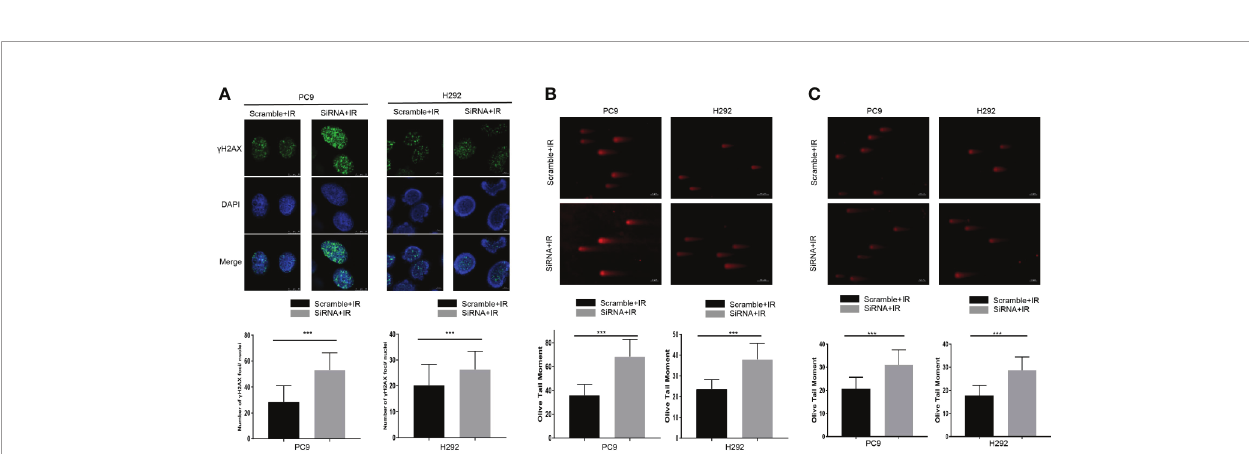
FIGURE 4 | Cancer-IgG silencing attenuates lung adenocarcinoma resistance to radiation therapy. (A) Silencing cancer-IgG expression inhibited the DNA double- strand break repair ability of PC9 and H292 cells, and the number of g H2AX fl uorescence foci in the nucleus increased. Count 50 cells in each group in the experiment. *** P < 0.001 (n=50). (B, C) The DNA double-strand break repair capacity was impaired in PC9 and H292 cells with cancer-IgG knockdown, and the Olive tail moment was extended. Count 50 cells in each group in the experiment. Scale bar, 50 m m. (B) Irradiation 4 Gy; (C) Irradiation 2 Gy. *** P < 0.001